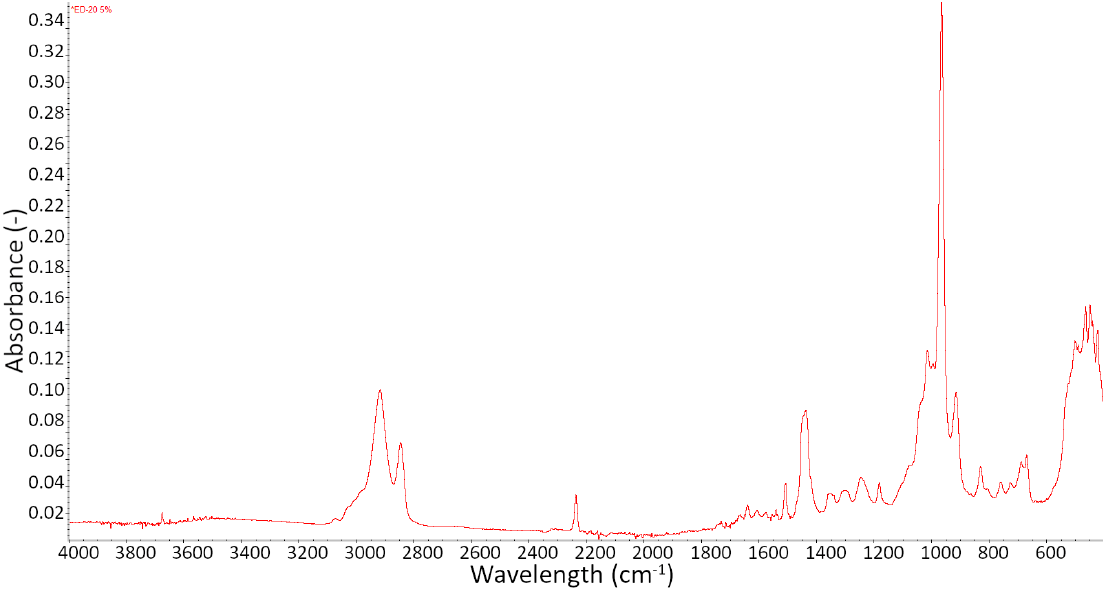
Figure 8. FT-IR spectrum of NBR modified with 5 wt.% of ED-20 after vulcanization. Analogous absorption peaks are present in the spectrum of ED-20 10% (Figure 9), except that the resin-derived peaks become larger, so that a few more typical for ED-20 ones come to the significant level. They are 3400 cm − 1 belonging to the -OH group in the resin, 1500 cm − 1 from the C-C bond of the aromatic groups of the resin, 1250 cm − 1 from the C-O bond of the aromatic ring, and 1200 cm − 1 from aliphatic C-O groups. There is also a significant increase in the peak typical for the content of epoxy groups.